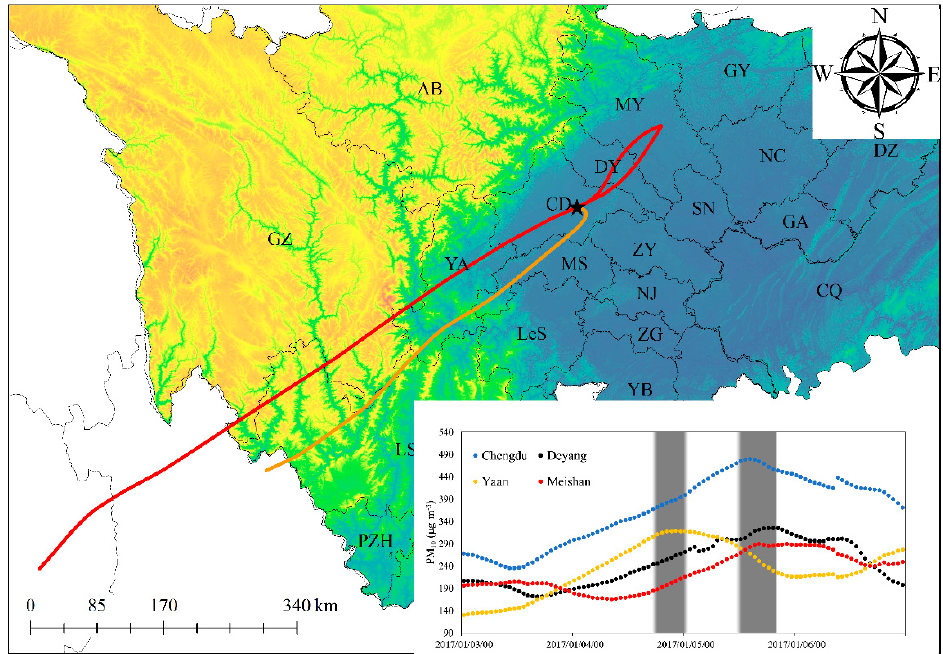
Figure 9. Air transport clustering trajectory in Chengdu during heavy pollution period, and the color of red and orange represent two different trajectories. The right picture shows the hourly average PM 10 concentration of the four cities during the event. The shaded part represents the arrival time of the peak concentration.